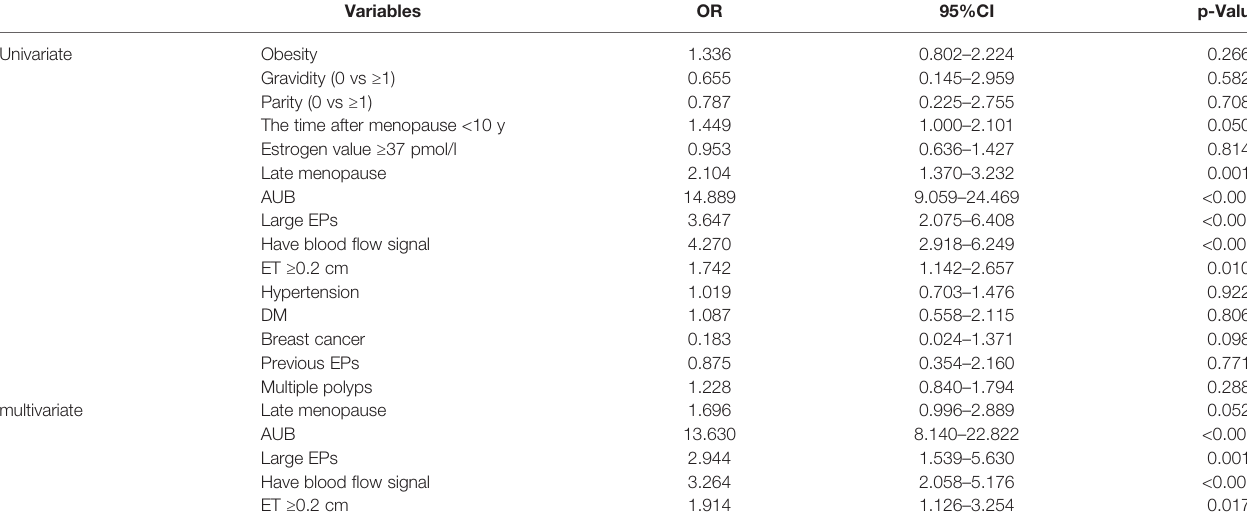
TABLE 4 | Univariate and multivariate analysis of demographic and clinical data between benign and malignancy groups in postmenopausal patients in training set. Variables